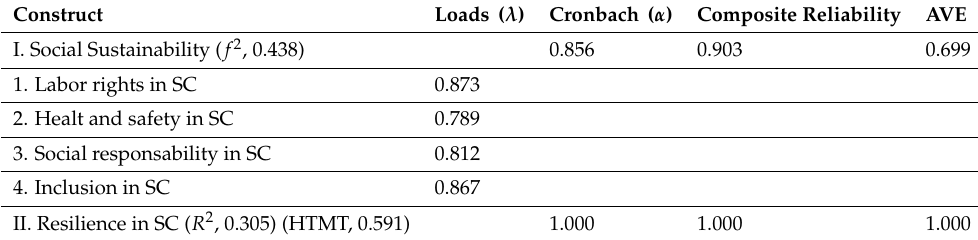
Table 4. Individual reliability of the item and convergent validity of the construct: second order.